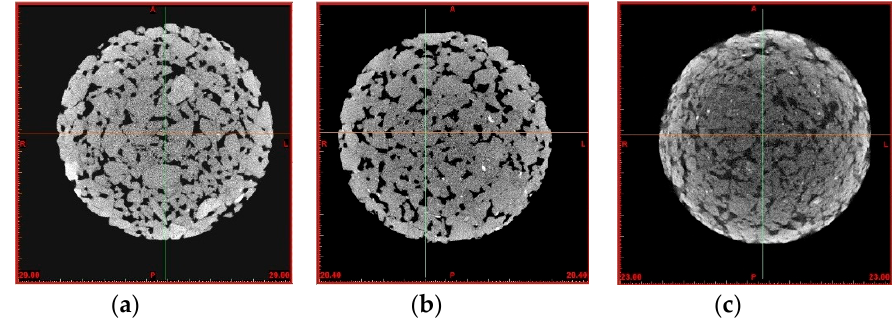
Figure 7. Computed tomography ( a ) PA-SCC; ( b ) PA-SLL; ( c ) PA-ELL.